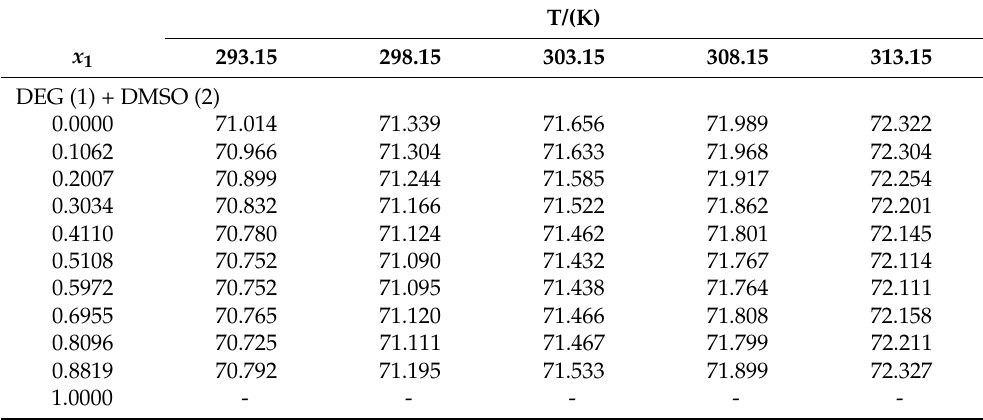
Table A6. Apparent molar volumes of DMSO, V φ ,2 (cm 3 · mol − 1 ), for binary systems DEG + DMSO and apparent molar volumes of DMSO, V φ ,2 (cm 3 · mol − 1 ), for binary system MDEA + DMSO in the temperature range from 293.15 to 313.15